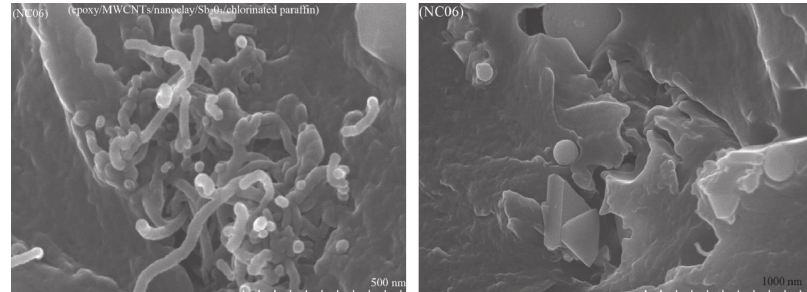
Figure 6: FE-SEM of the sample nanocomposites: epoxy Epikote 240/MWCNTs/nanoclay/ Sb